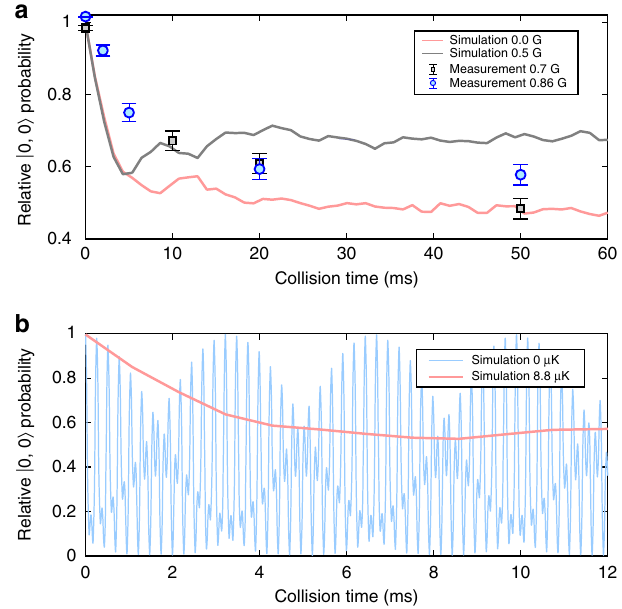
Fig. 5 Spin population dynamics at low bias fi eld. a Comparison between simulated and measured relative populations of |0, 0 〉 at low magnetic bias fi elds. Error bars in the experimental data denote the standard error of the mean. b Simulation of the |0, 0 〉 population as a function of collision time at two different temperatures and zero magnetic bias fi eld. The initial relative motional state for the zero temperature simulation was the interacting groundstate of the relative motional Hamiltonian h 0 ; 0 j ^ H j 0 ; 0 i . The zero temperature simulation was performed on a truncated basis of 316 relative motional modes. Source data are provided as a Source Data fi